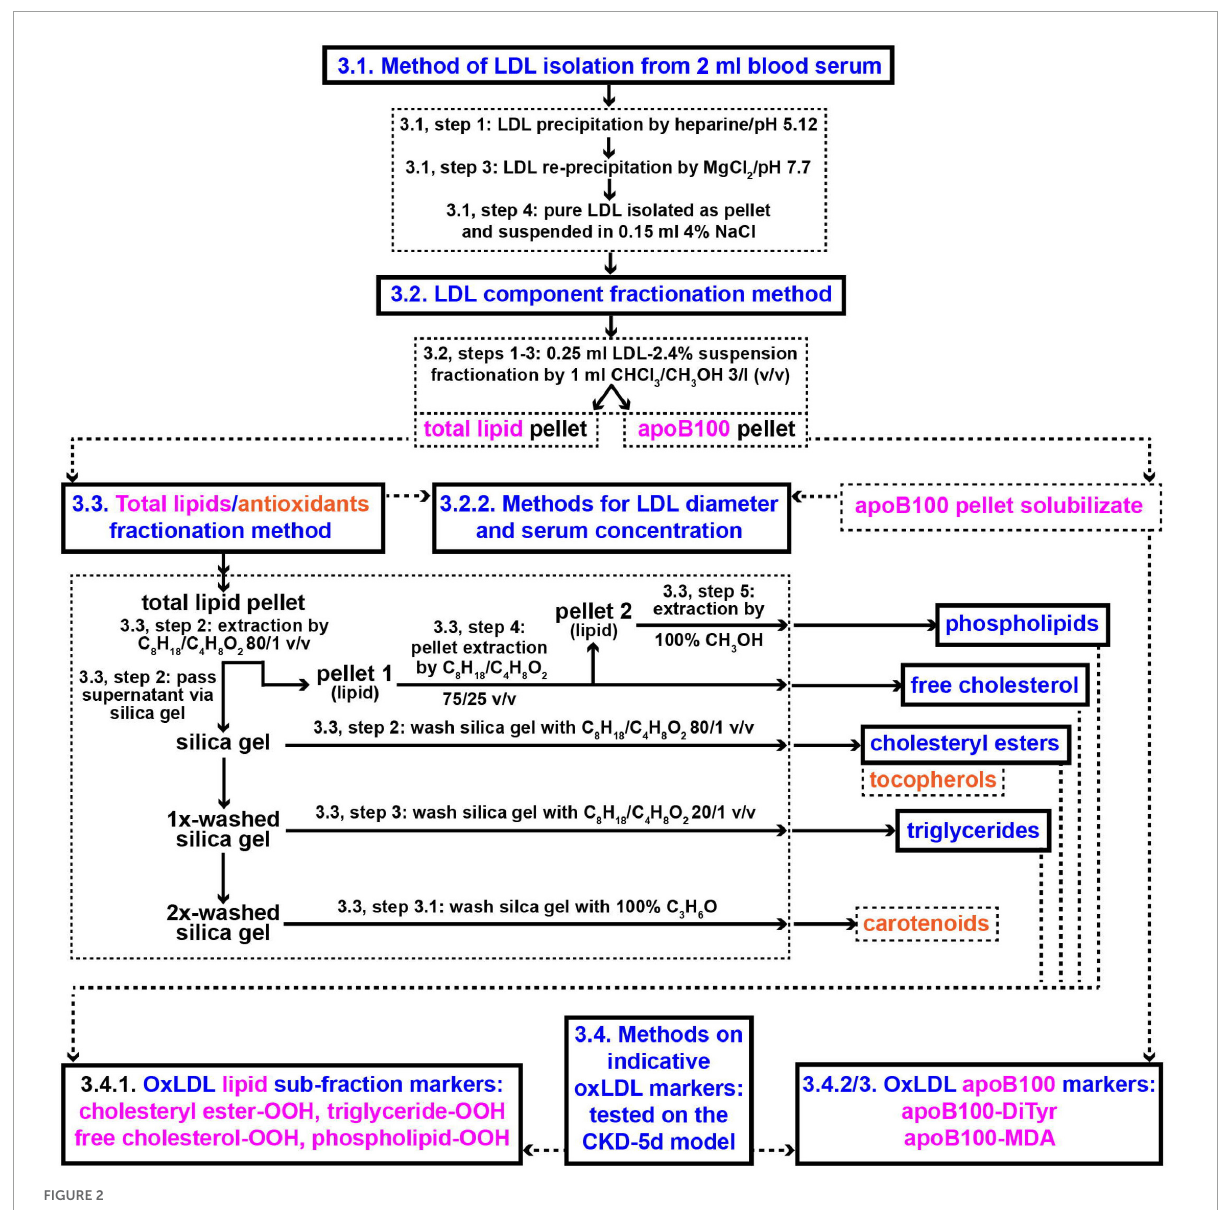
FIGURE2 Methods outline protocols for the development of new clinical markers for CVD risk assessment based on oxLDL. Numbers in panels designate protocols’ sub-sections and steps in section “Methods”. CHCl 3 /CH 3 OH, chloroform/methanol; C 8 H 18 /C 4 H 8 O 2 , iso-octane/ethyl acetate; C 3 H 6 O,